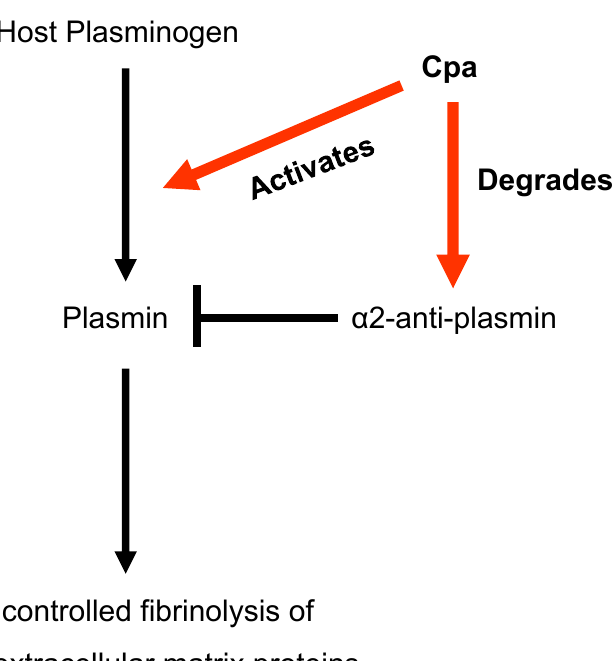
Figure 3. Mechanisms of plasminogen activation by C. sakazakii and its role in bacterial virulence. It is thought that a complex with plasminogen is formed when Cronobacter plasminogen activator (Cpa) is expressed by invasive C. sakazakii (cells invading a host’s circulatory system), which causes proteolysis and conversion of host plasminogen to plasmin. Plasmin bound (conjecture) to bacterial cell surfaces then catalyzes the degradation of fibrin polymers (fibrinolysis) which are major components of fibrin clots and the extracellular matrix. Additionally, Cpa can also inactivate α 2-anti-plasmin which normally would break down plasmin. Thus, there is an unlimited activation of plasmin leading to increased fibrinolysis which in turns allows for increased invasiveness.